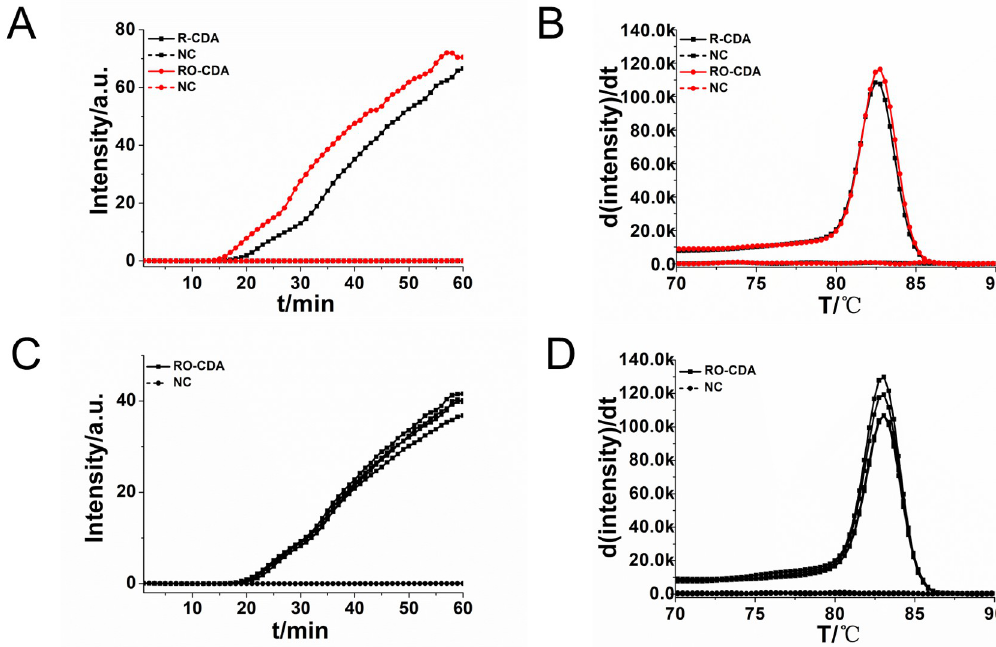
Fig 3. Amplifications of R . raoultii DNA by R-CDA and RO-CDA monitored by real-time PCR. (A) Amplification plot of real-time R-CDA and RO-CDA for R . raoultii DNA. (B) Melting curve analysis of CDA and RO-CDA products. (C) Repeatability analysis of the RO-CDA monitored by real- time PCR at 60˚C. (D) Repeatability analysis of melting curve analysis of RO-CDA products. PC, positive reaction with the template; NC, negative control reaction without the template.